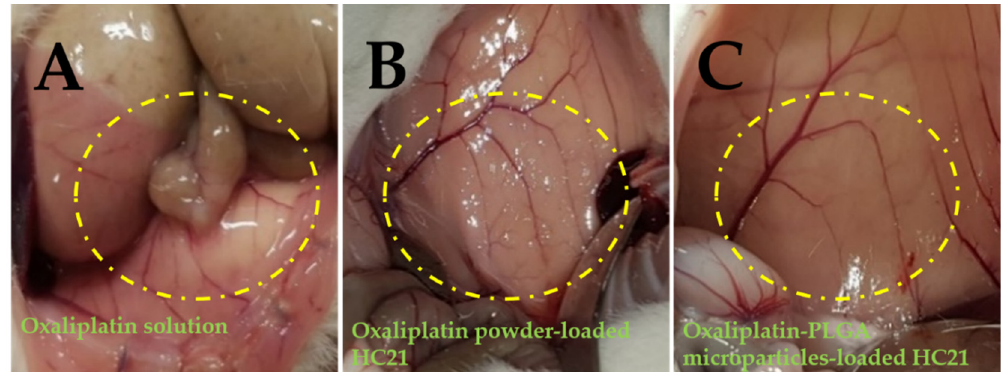
Figure 5. Photographical expression of in vivo anti-adhesion efficacy observed in rats after introducing intra-peritoneal injury. ( A ) oxaliplatin solution; ( B ) oxaliplatin powder-loaded HC21 hydrogel; and ( C ) oxaliplatin-PLGA microparticles-loaded HC21 hydrogel. HC21 hydrogel samples exhibited an efficient anti-adhesion barrier effect towards the injury.